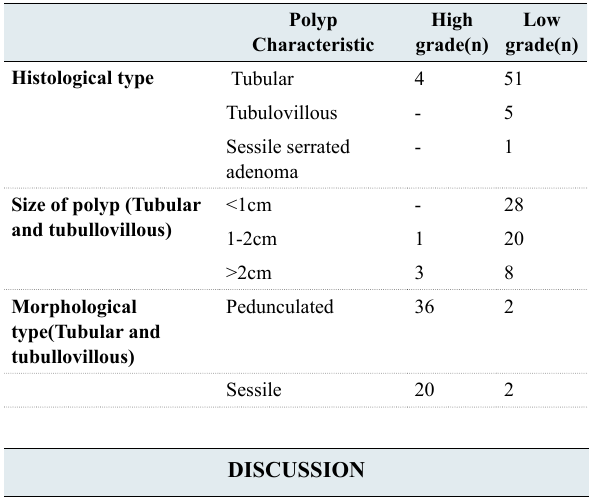
Table 2: Characteristic of adenomatous polyps and their relationship with a grade of dysplasia